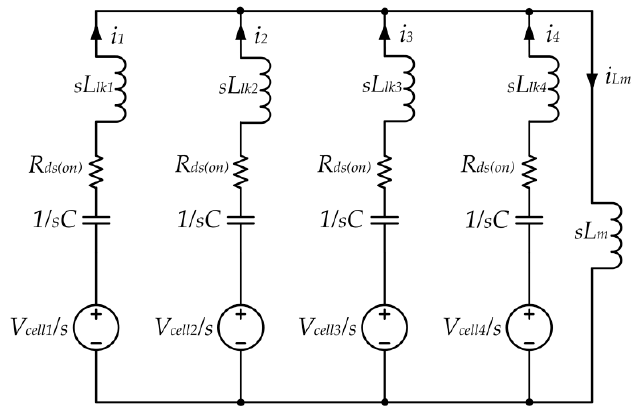
Figure 4. Laplace transform circuit of mode 1.